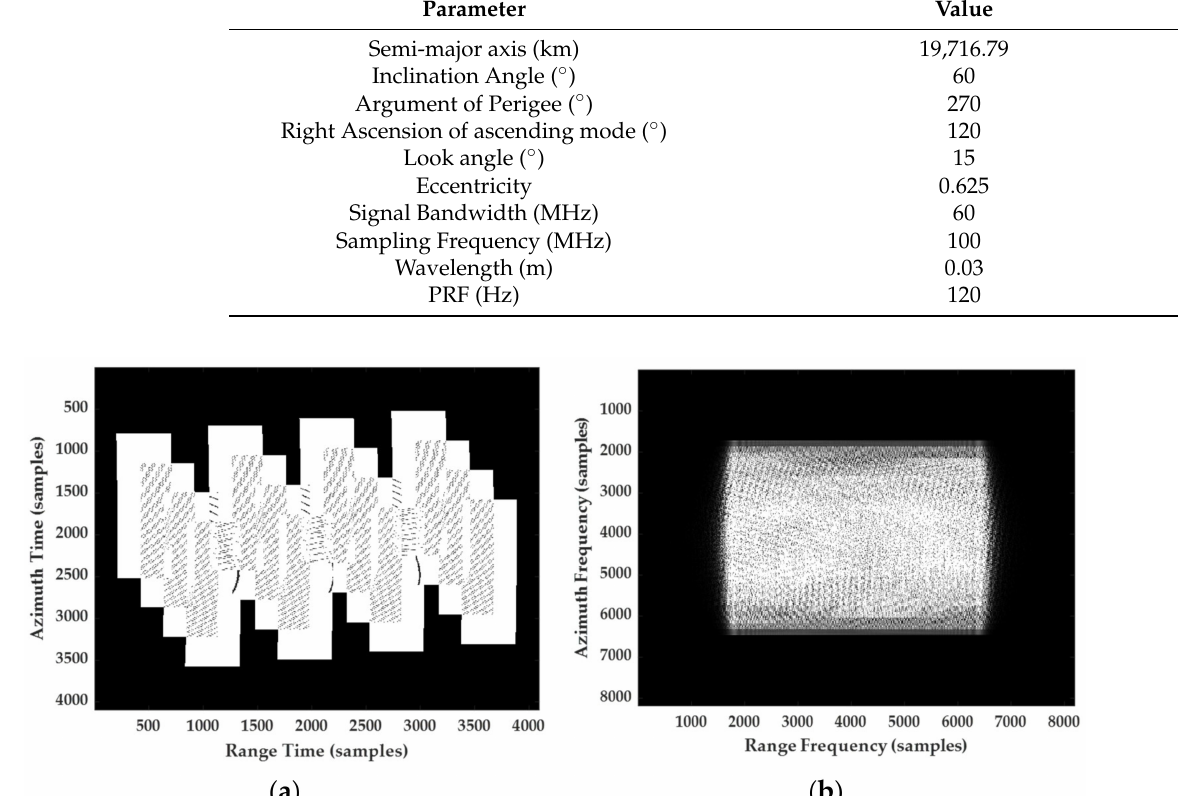
Figure 13. Original echo data and 2D-spectrum of focused data. ( a ) The raw SAR data. ( b )